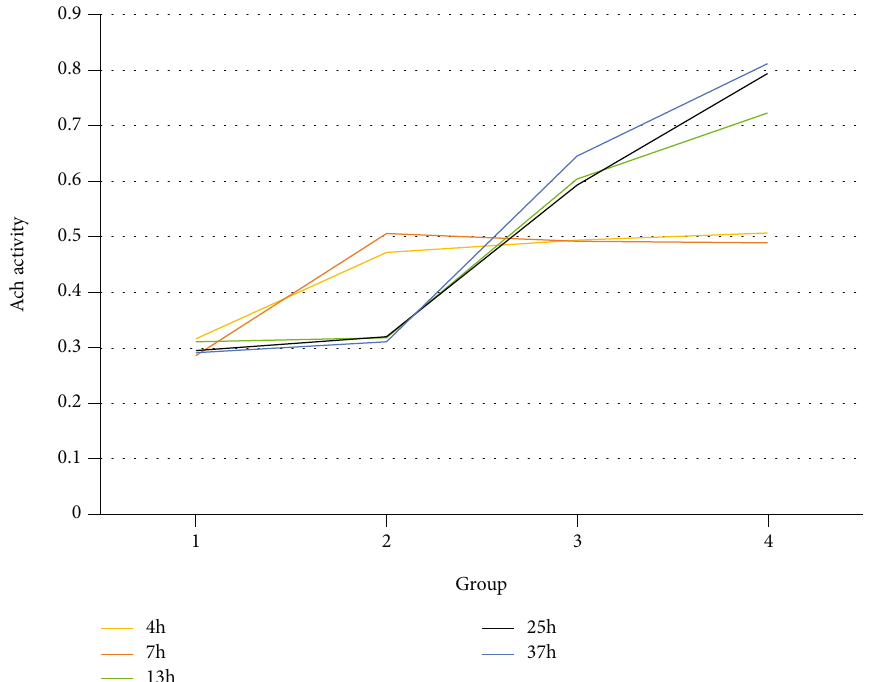
Figure 4: After administration Ach level in all